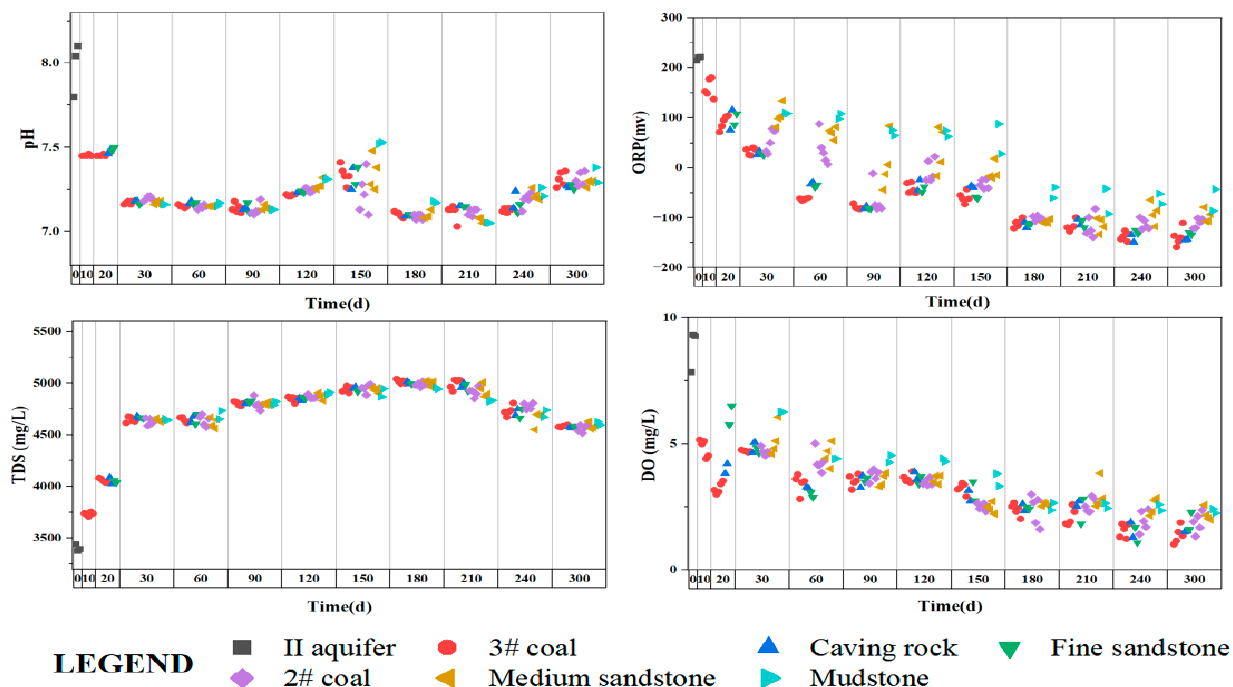
Figure 4. Spatiotemporal change scatter plots of pH, ORP, TDS, and DO. ORP, pH, and DO showed a significant negative correlation with TDS, indicating that the increase in TDS in the goaf water was related to mineral oxidation. At the beginning of the experiment (0–30 days), pH and DO decreased rapidly and then gradually stabilized. After 300 days of the experiment, the pH of the goaf water decreased from 8.01 to 7.26. DO decreased from 9.31 mg/L to 1.01 mg/L. The ORP also showed a gradual decrease and a negative value after 30 days, indicating that the goaf water changed from an oxidizing environment to a reducing environment during the experiment. In addition, DO of the water samples taken from the 3# coal layer was the lowest, and the reducibility was the strongest most of the time, while the mudstone layer at the top of the goaf was the opposite. In this work, IC and ICP-OES were, respectively, used to determine the concentrations of major anions and cations in the experimentally collected water samples from each rock layer and have been plotted as half box-and-whisker diagrams, as shown in Figure 5. The magnitude of the cation mass concentration of the goaf water in the simulation experiment was Na + + K + > Ca 2+ > Mg 2+ , and the anions were SO 42 − > HCO 3 − > Cl − . The concen- trations of major anions and cations in the water samples of each stratum did not differ significantly, and they all increased rapidly at the beginning of the experiment (0–30 d) and gradually stabilized after reaching a peak after 30 days. The same is the mineral content change, indicating that water–rock interaction is mainly concentrated in the early stage of goaf water formation. However, there was no significant difference in ions in the water samples of different sampling layers at the same period (the specific spatiotemporal variation rule is shown in Table S1). As the fracture rate of the goaf increased compared with the original rock strata, the cross-sectional area of ion diffusion was expanded, thus intensifying the diffusion effect of ions in the goaf water. The linear correlation coefficient method was used to analyze the relationship between ion concentration and TDS of the goaf water, and the results are shown in Figure 6. In Figure 6, the concentration of each ion in the water samples increased with the increase in TDS, where R 2 (Na + + K + ) = 0.73943, R 2 (Ca 2+ ) = 0.81959 and R 2 (SO 4 2 − ) = 0.79314, which indicates Na + + K + , Ca 2+ , SO 4 2 − ,